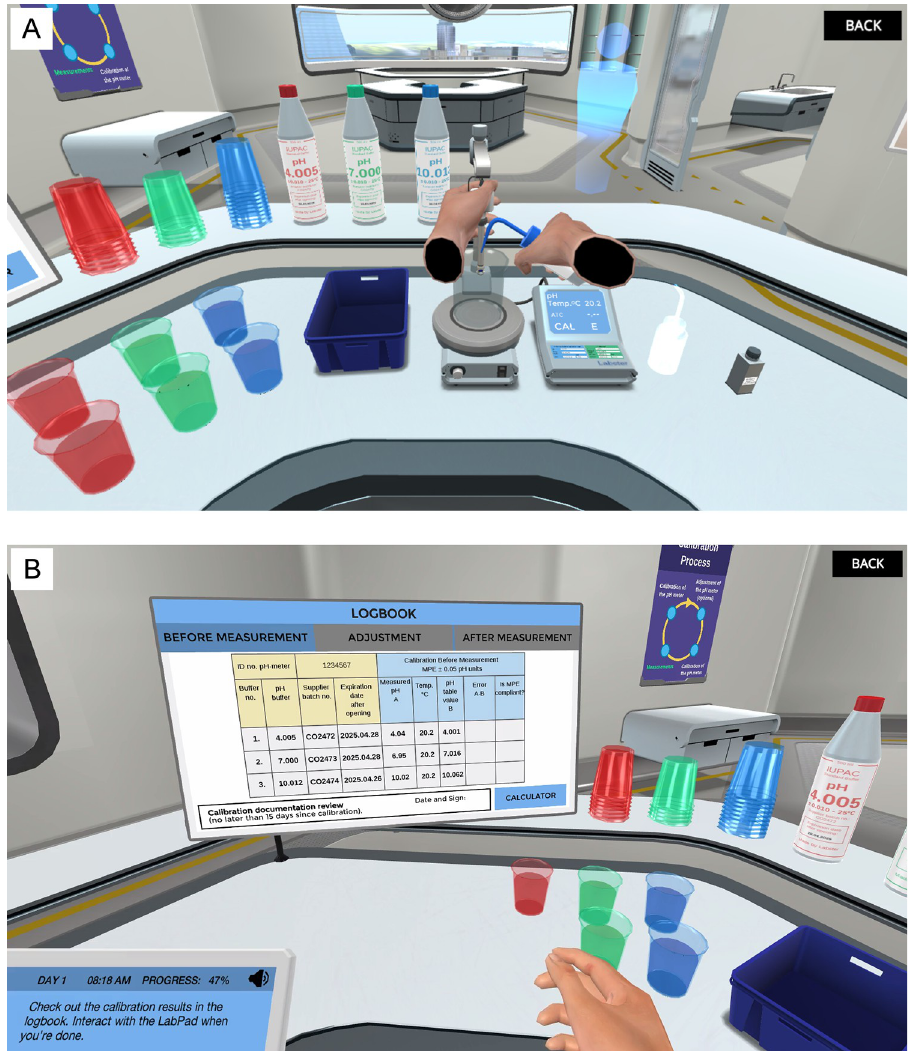
Fig 1. Virtual reality (VR) simulation on pH meter operation. A: VR simulation task to flush the pH meter electrode with water from a wash bottle. B: In-game challenge to evaluate pH calibration points and decide on the next steps.